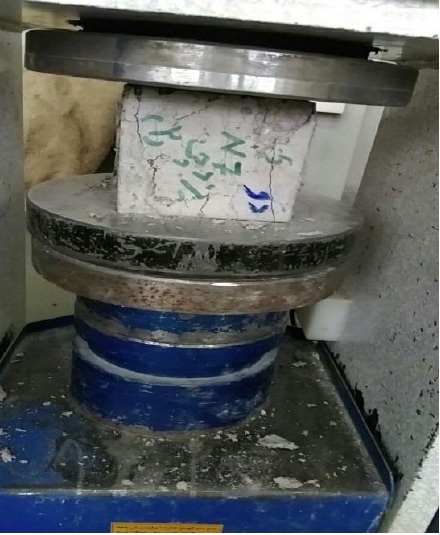
Figure 3. A cubic sample during the compressive strength test.